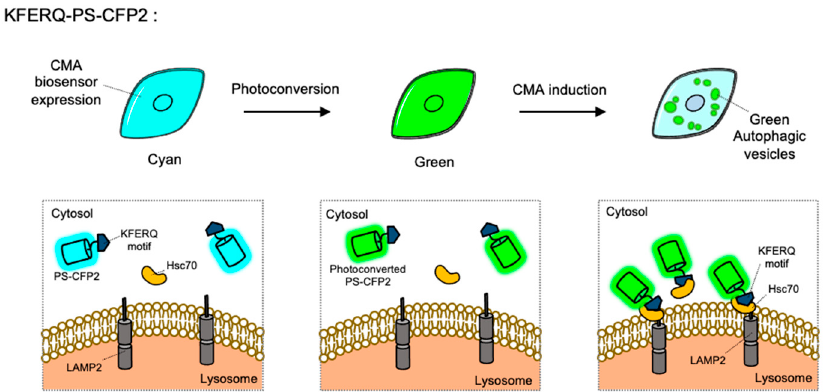
Figure 5. The chaperone-mediated autophagy (CMA) biosensor. The CMA biosensor is composed of the KFERQ-motif and PS-CFP2, a photoconvertible cyan FP. Before photostimulation, the KFERQ-PS-CFP2 is observed as cyan color in whole cell area (left). Upon illumination, PS-CFP2 in the CMA biosensor changes its color to green (middle). After the induction of CMA, the KFERQ-motif in the CMA biosensor is recognized by Hsc70, which can deliver it to LAMP2 at lysosomes. Thus CMA process can be visualized by green puncta (right).